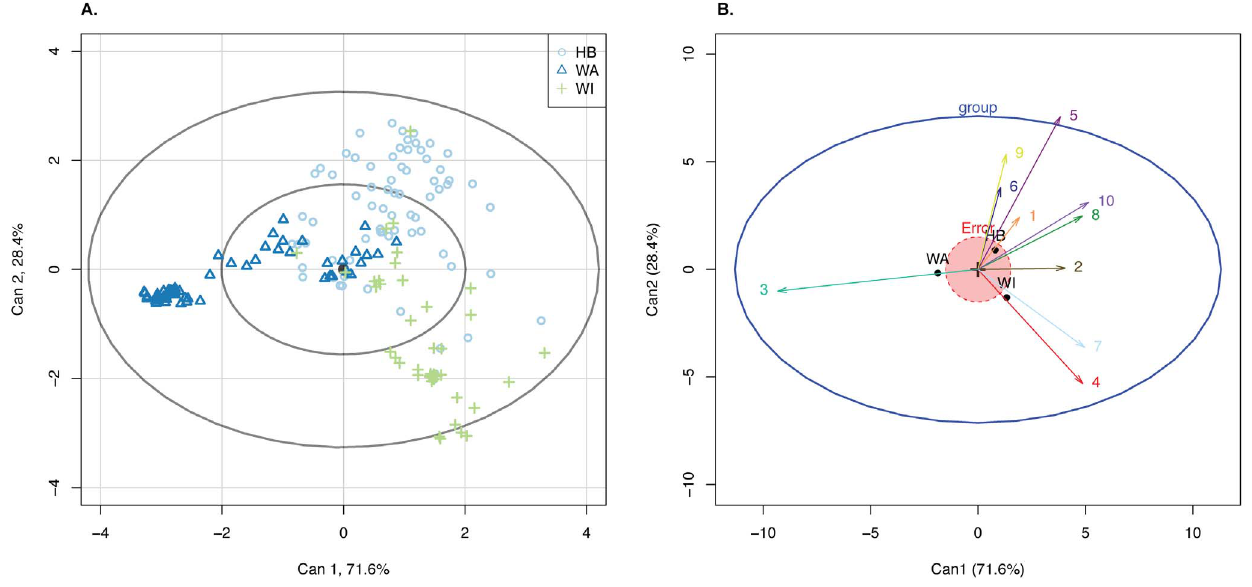
Figure 4.Canonical discriminant analysis on the Saccharomycescerevisiae dataset. (a) Mapping the individual data according to the CDA variables. The inner ellipsoid contains 50% of all individuals, the outer ellipsoid contains 95% of all individuals. Individuals are colour- and shape- coded according to their respective sampled region. (b) The HE plot shows the relation of variation in the group means on two variables relative to the error variance. The coloured arrows indicate the position of the inferred populations relative to the axes obtained by the canonical discriminant analysis. The black points indicate predefined populations (WA = West Auckland; WI = Waiheke Island; HB = Hawke’s Bay) while numbers at the arrows indicate inferred populations.